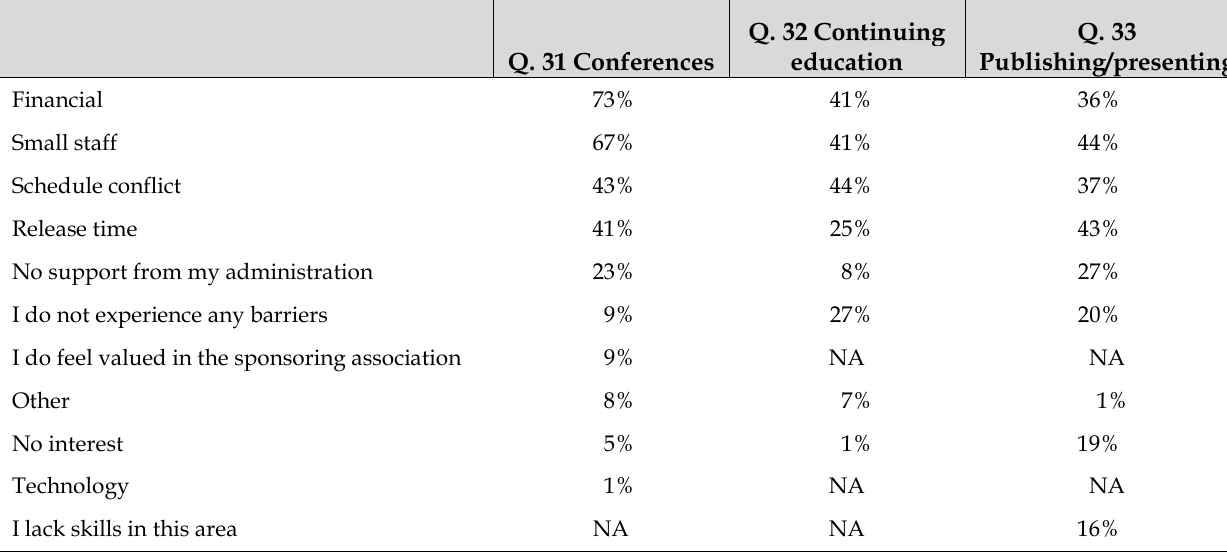
Table 2 Barriers to professional